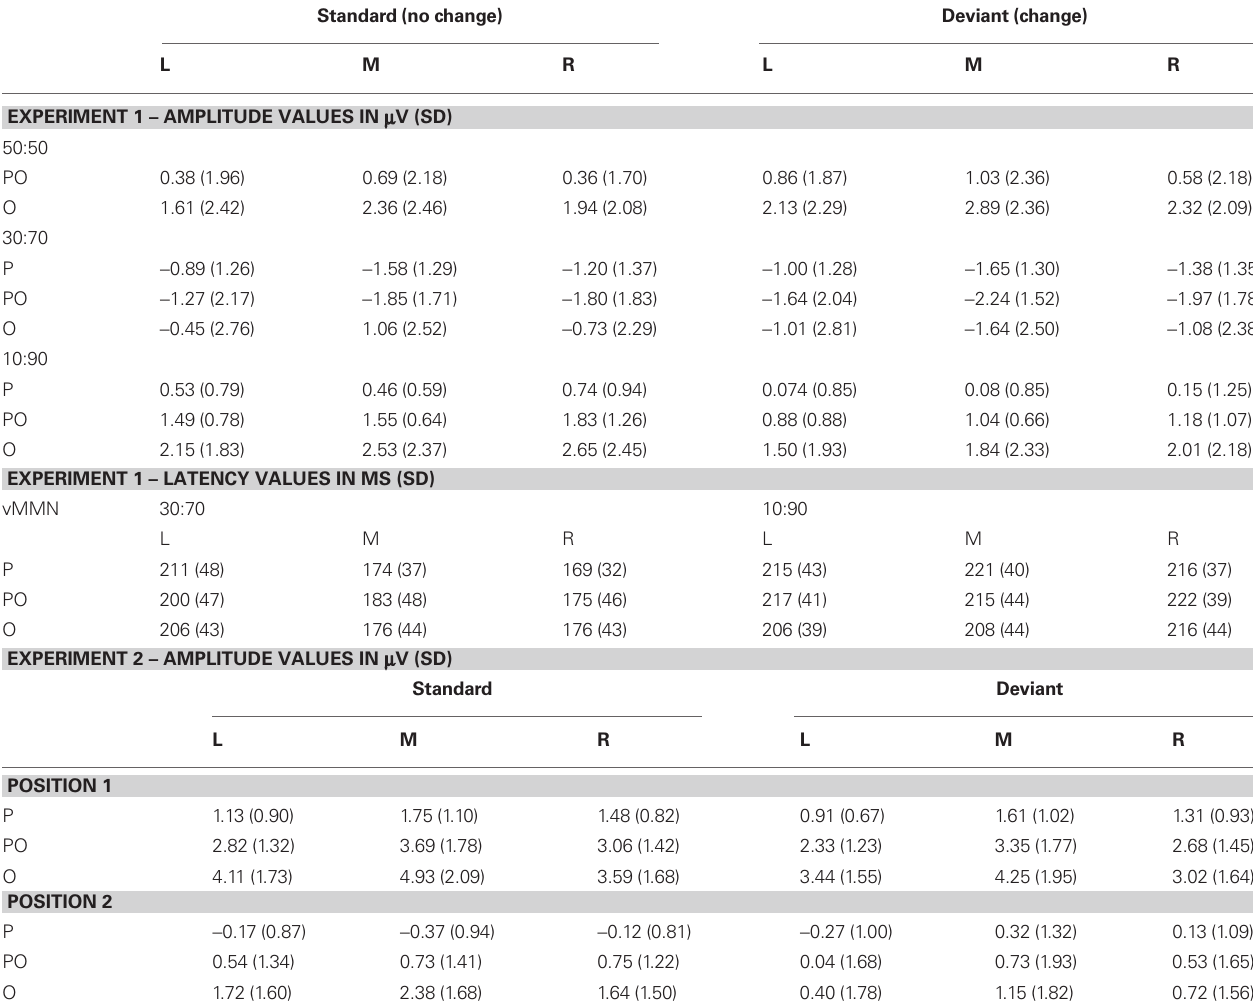
Table 1 | interval amplitude and peak latency values (and SD) used for statistical analyses of erPs to standards and deviants from experiments 1 and